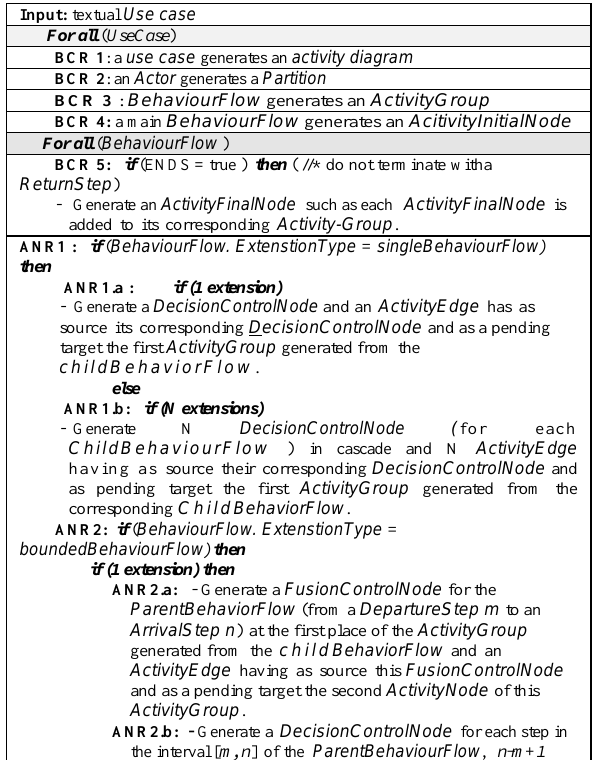
Table1 . Algorithmic presentation of transformation